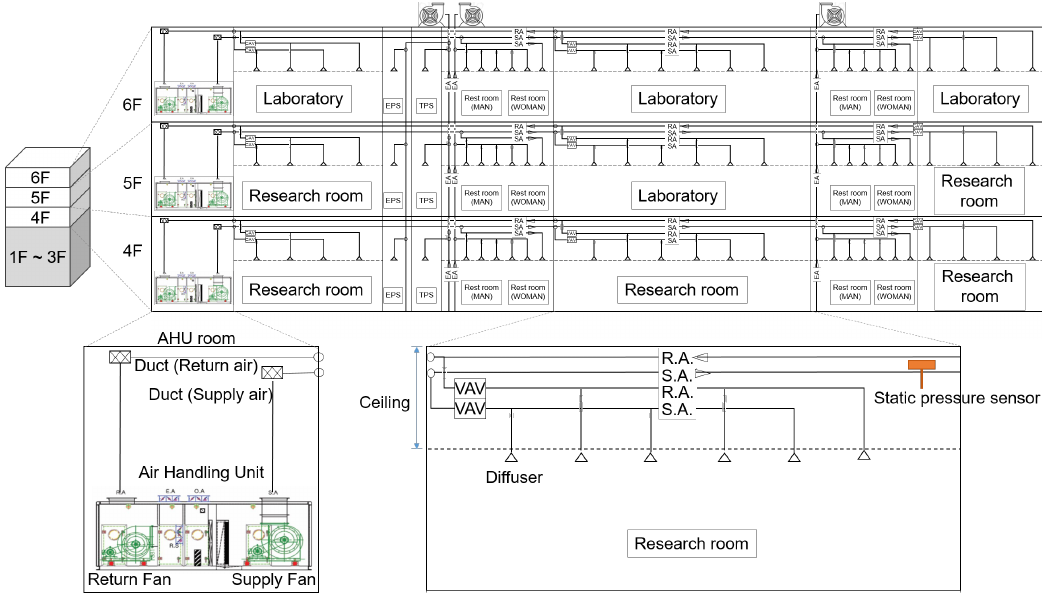
Figure 13. Heating, Ventilation, and Air Conditioning (HVAC) system structure of target